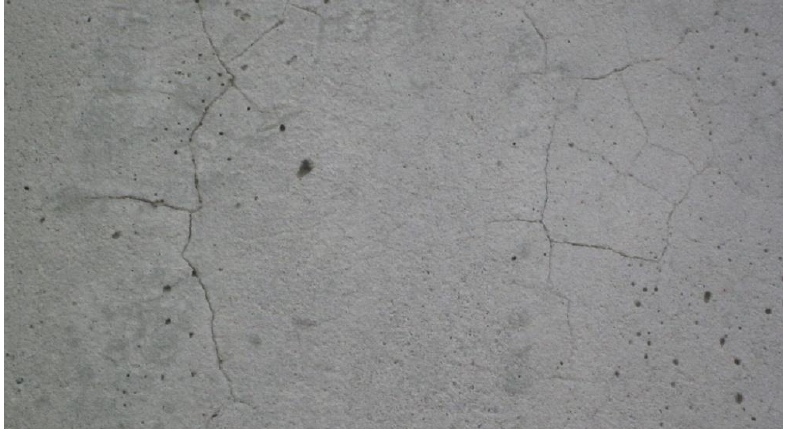
Figure 4. Early-age random cracks that occurred in a concrete floor slab; most of these cracks appeared within 42 days after placing of concrete; the slab was cured using thermal curing blanket.